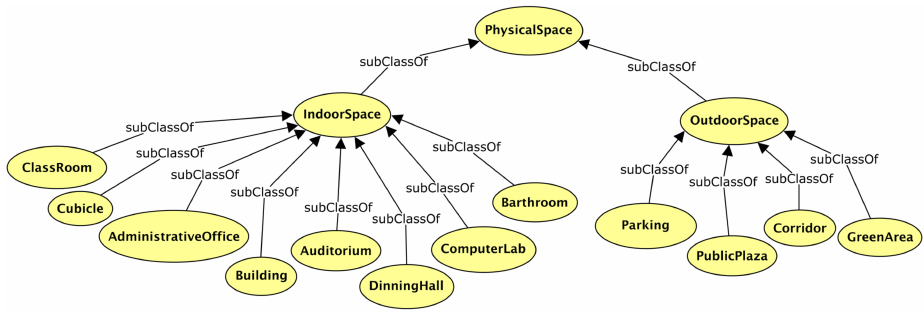
Figure 3. Location